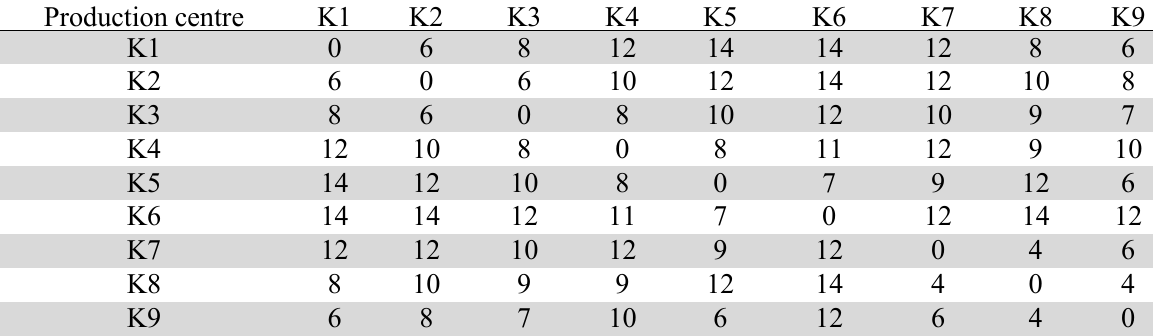
Distance matrix between production centers Production centre